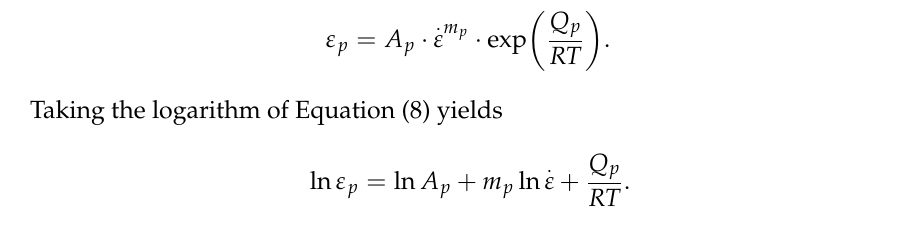
 and  under different temperatures and strain rates. p c